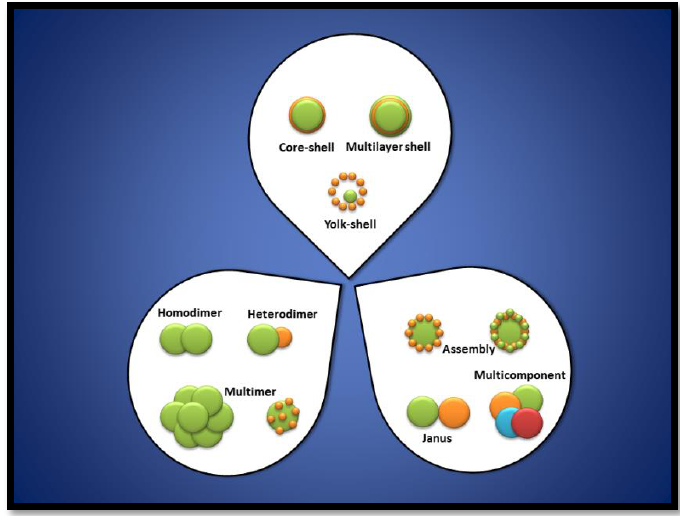
Figure 1. Di ff erent possibilities for metal oxides (MO) / noble metal nanohybrid Figure 1. Different possibilities for metal oxides (MO)/noble metal nanohybrid materials.